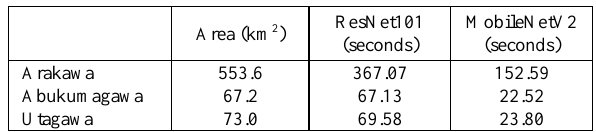
Table 7. Comparison of processing time during testing